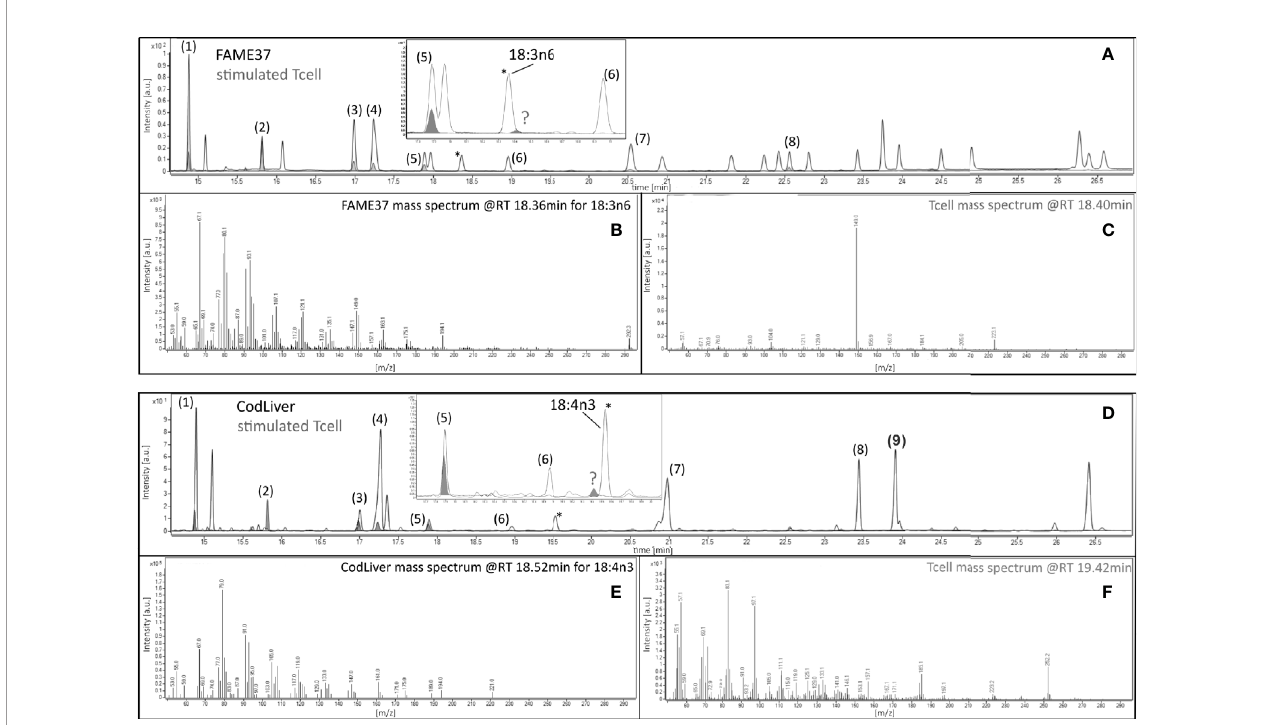
FIGURE 3 | Gas chromatography – mass spectrometric analysis of 18:3n-6 and 18:4n-3 in 48-h mitogen-stimulated CD3 + T cells. Chromatographic separation offatty acid methyl esters (FAMEs) from (A) the 37 FAMEs standard mixture and (D) cod liver (gray line), and from stimulated T cells (gray fi ll) after 48-h incubation with concanavalin A (Con A). Peaks were (1) 16:0, (2) 17:0 internal standard, (3) 18:0, (4) 18:1n-9, (5) 18:2n-6, (6) 18:3n-3, (7) 20:1n-9, (8) 20:4n-6 (FAME37), and (9) 20:5n-3 (cod liver standard). Insets show the positions of the closest peaks in T cells to authentic 18:3n-6 or 18:4n-3 peaks in 37 FAMEs standard (peaks marked by )? (B, E) Mass spectra of authentic 18:3n-6 or 18:4n-3. (C, F) Mass spectra of unknown peaks (marked )? *Marks peaks shown on the main chromatogram and expanded insert for orientation